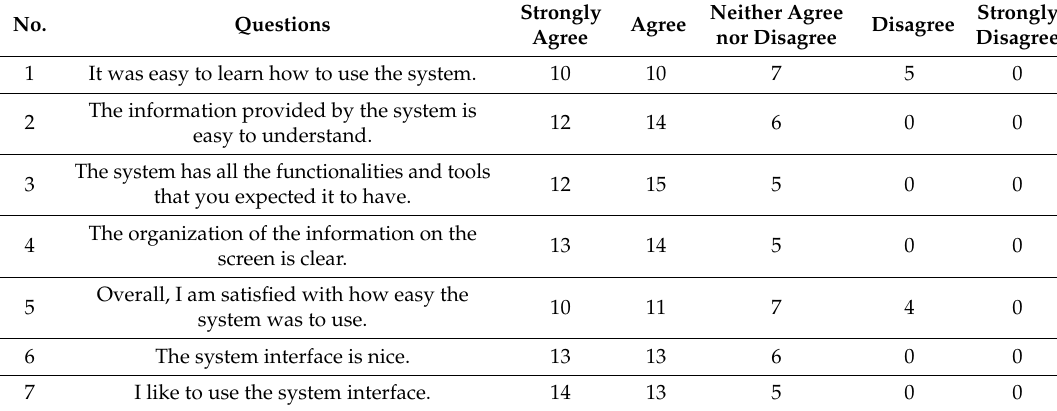
Table A3. Usability survey and